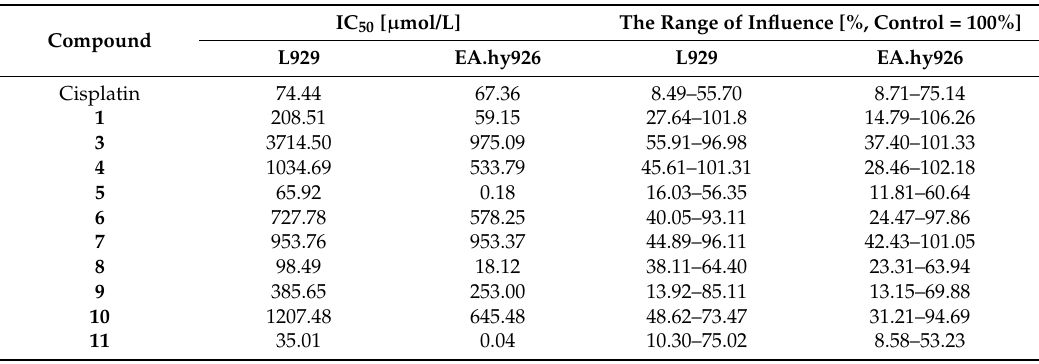
Table 4. Cell proliferation study